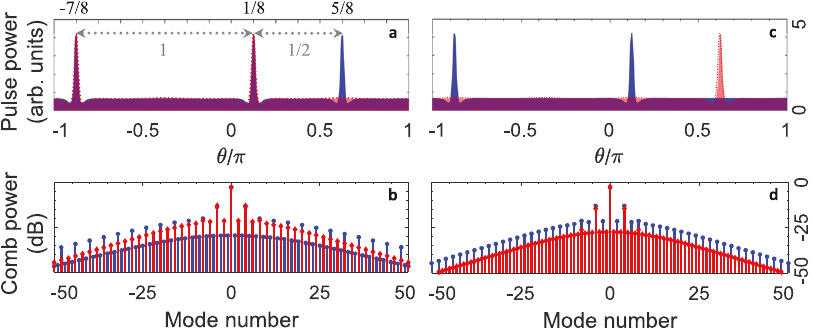
Fig. 7 Discrete time crystals before and after controlled state switching. The initial (blue) and fi nal (red) pulse trains per round-trip time ( a , c ) and frequency spectra ( b , d ) in the state switching procedures plotted in Fig. 6; a , b correspond to the example of Fig. 6a – c and c , d to that of Fig. 6d – f. The temporal delay between the soliton peaks are marked in a